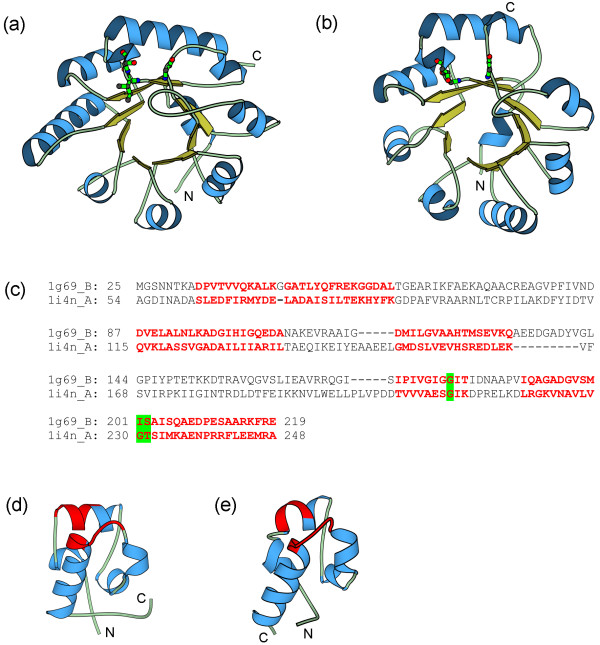
Homologous SCOP superfamilies. a) Ribbon diagram of thiamin phosphate synthase from Bacillus subtilis (PDB: 1g69[52], chain B) from the thiamin phosphate synthase superfamily. b) Ribbon diagram of indole-3-glycerophosphate synthase from Thermotoga maritima (PDB: 1i4n[53], chain A) from the ribulose-phosphate binding barrel superfamily. c) Pairwise alignment of representatives of the thiamin phosphate synthase and the ribulose-phosphate binding barrel superfamily produced by PSI-BLAST. Residue pairs that are equivalently aligned by DaliLite are showed in red bold letters. The three phosphate-binding residues in conserved positions in these two proteins are highlighted in green in the alignment and shown in ball-and-stick format in the structure figures. d) Ribbon diagram of α subunit C-terminal domain from E. coli RNA polymerase (PDB: 1lb2[54], chain B) from the "C-terminal domain of RNA polymerase alpha subunit" superfamily. Regions of the domain involved in DNA binding are in red. e) Ribbon diagram of the N-terminal domain of Rad51 from Homo sapiens (PDB: 1b22[55], chain A) from the "DNA repair protein Rad51, N-terminal domain superfamily". Putative DNA-binding surface is in red.